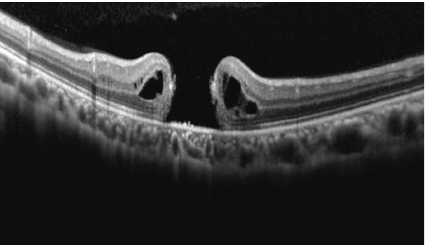
Figure 1: Optical coherence tomography (OCT) image showing full thickness macular hole with sharp margins and irregular surface of surrounding retina.